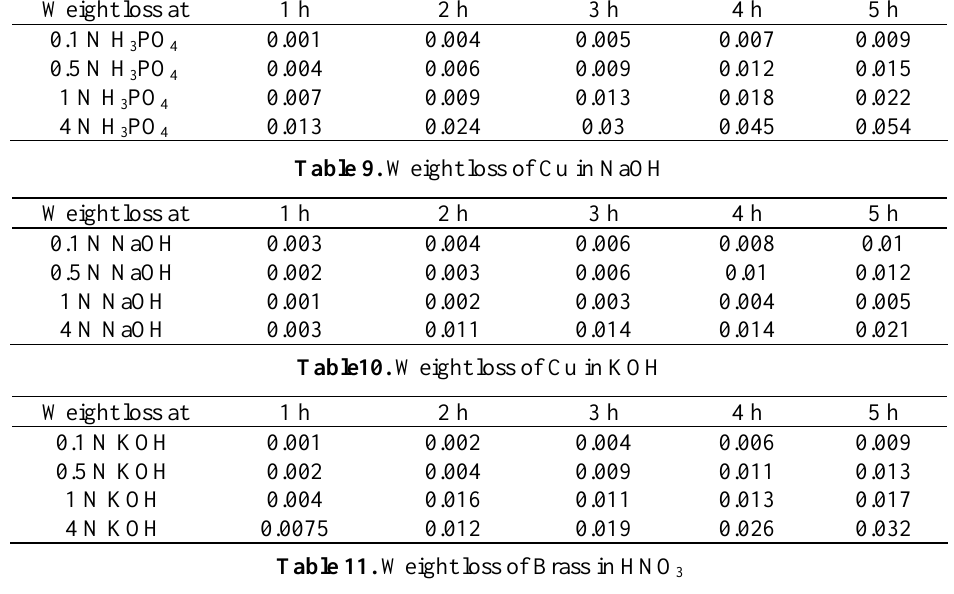
Table 8. Weight loss of Cu in H